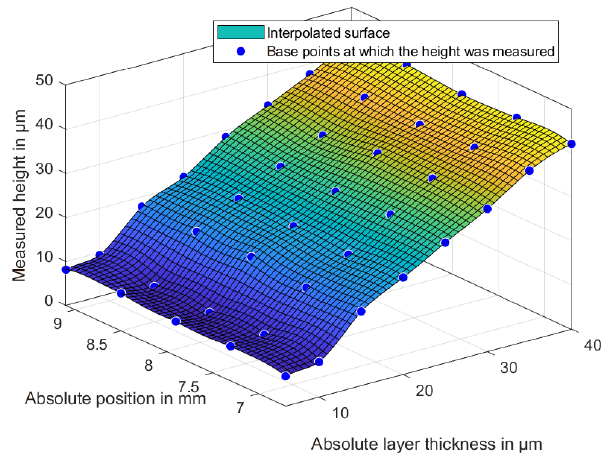
Figure 5. Nanomeasuring machine NMM-1 with integrated inter- ferometric measuring head and thin-film thickness standard.